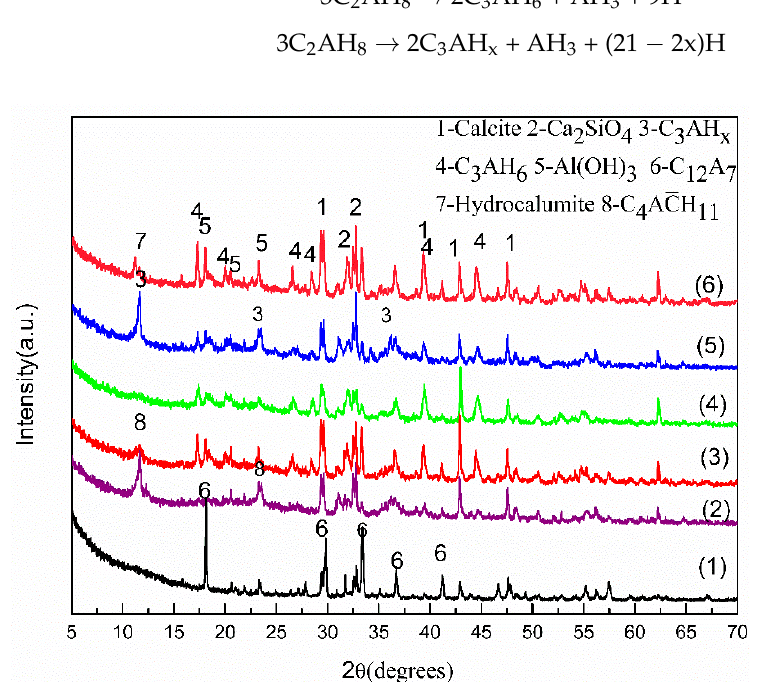
Figure 2. XRD patterns of (1) raw slag, (2) 20H-slag, (3) 40H-slag, (4) 60H-slag, (5) 80H-slag, and (6) 100H-slag.